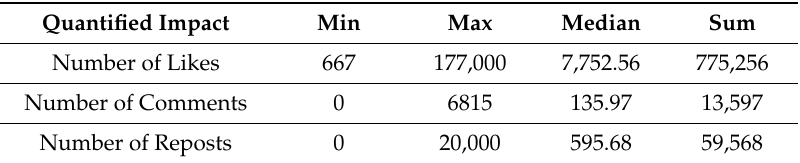
Table 3. The distribution of the Quantified Impact